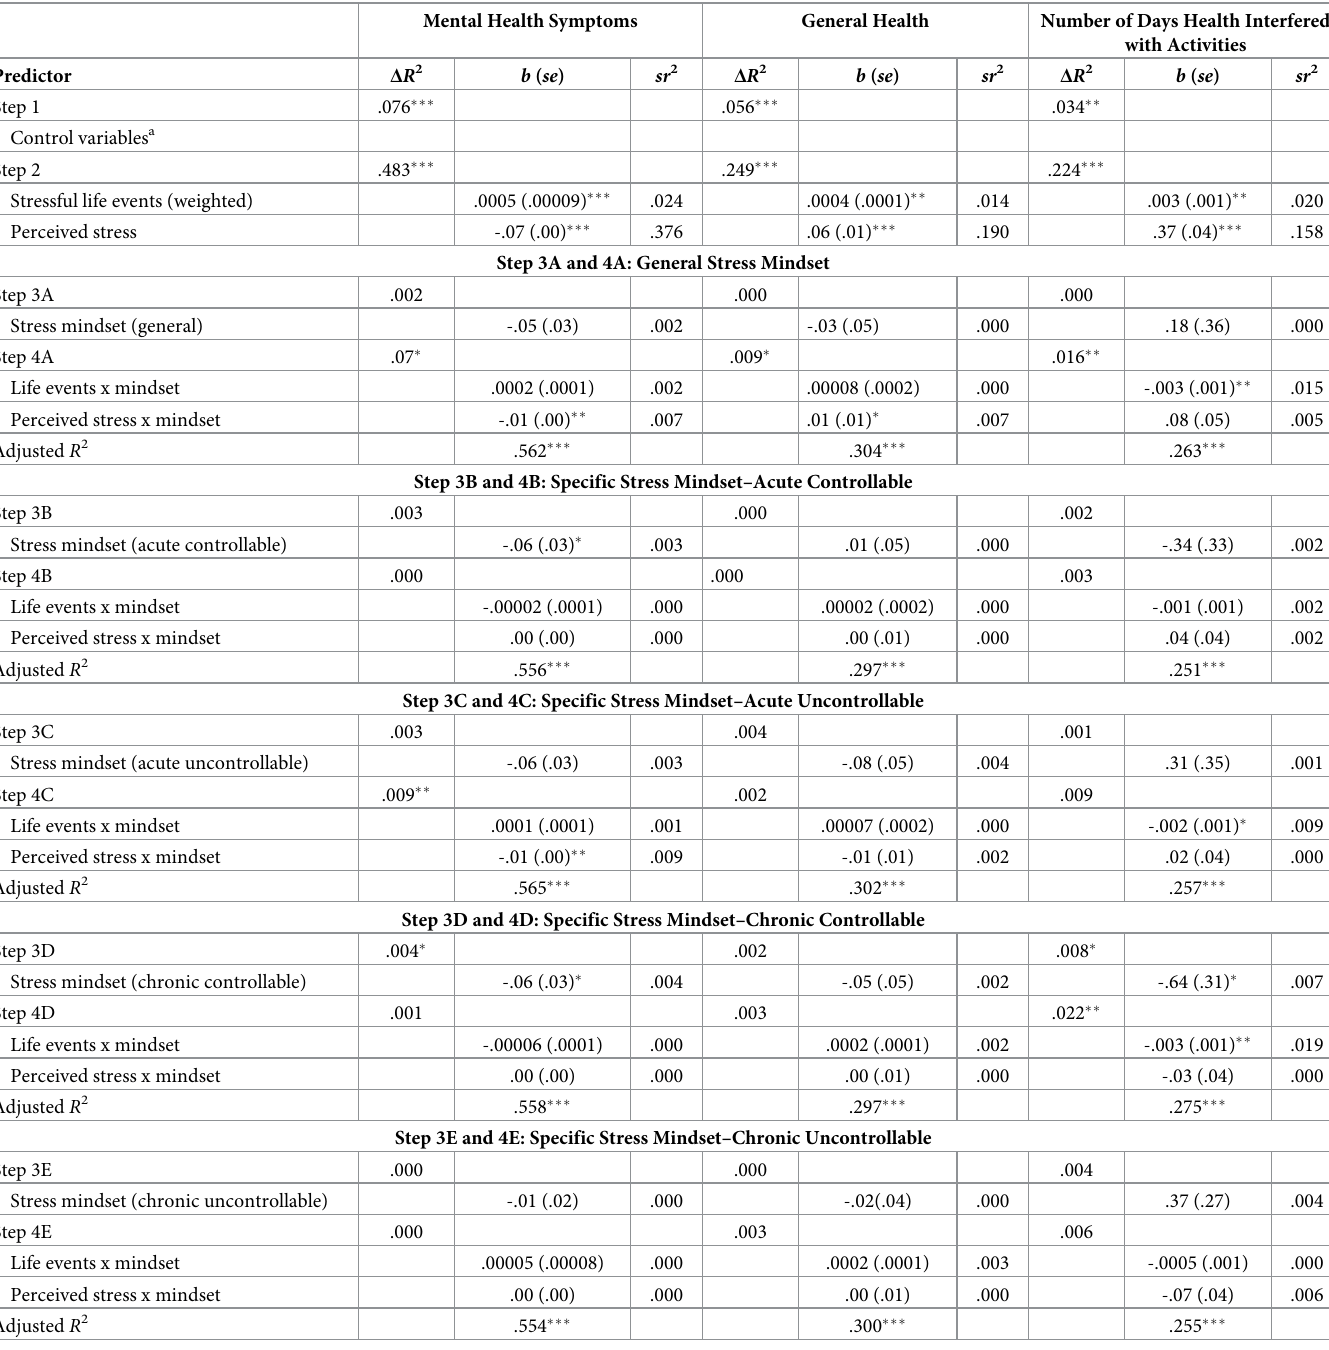
Table 4. Hierarchical multiple regression analyses predicting health measures from history of stressful life events, perceived stress, and general stress